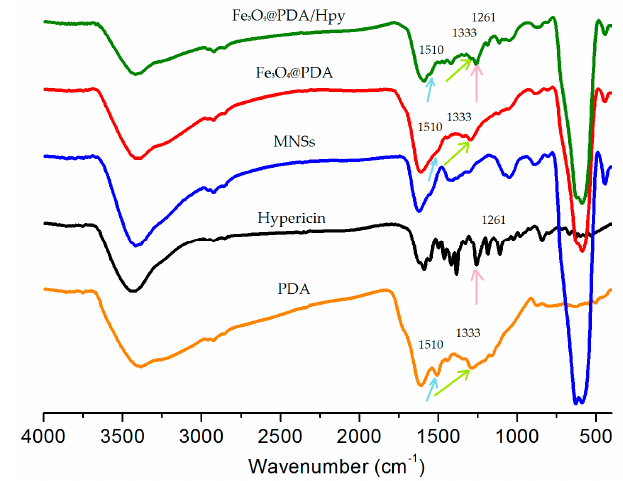
Figure 1. FTIR spectra of Fe 3 O 4 @PDA/Hyp, Fe 3 O 4 @PDA, MNSs, Hypericin and polydopamine (PDA).